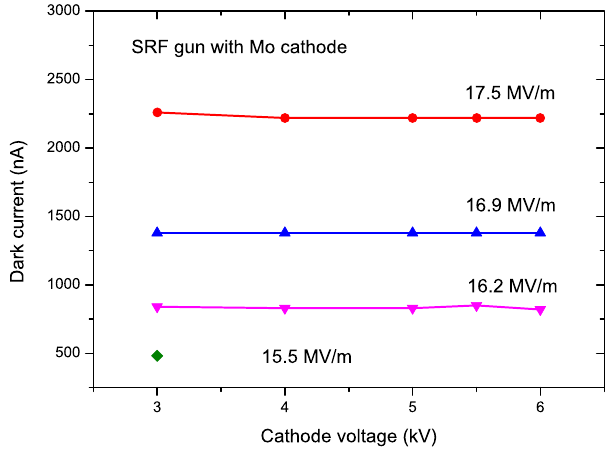
voltages.FIG. 8. Dark current vs cathode voltage for the cavity with Mo cathode.